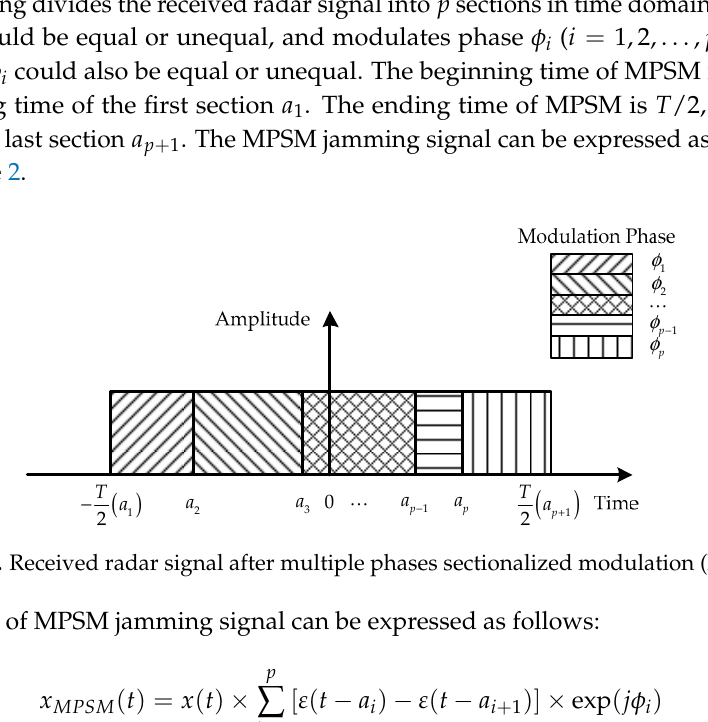
Figure 1. Received radar signal.